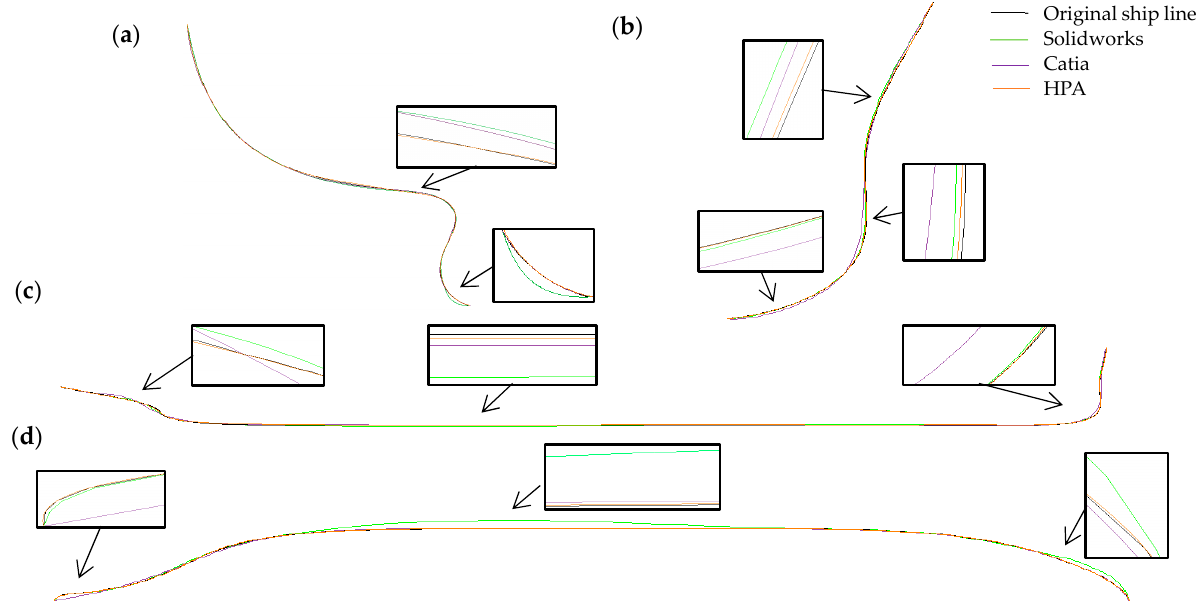
Figure 19. Fitting results of ship line of ( a ) cross section stern, ( b ) cross section bow, ( c ) longitudinal section and ( d ) waterline surface with Solidworks, Catia and HPA .